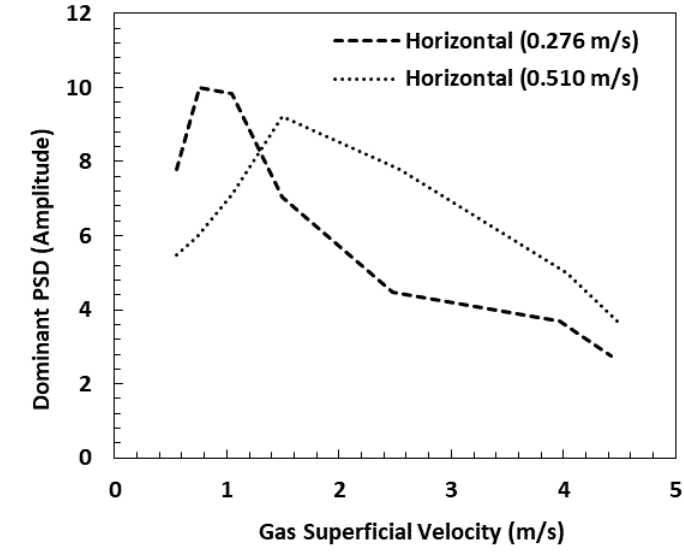
Figure 12. The max amplitude of PSD as a function of the superficial gas velocity.